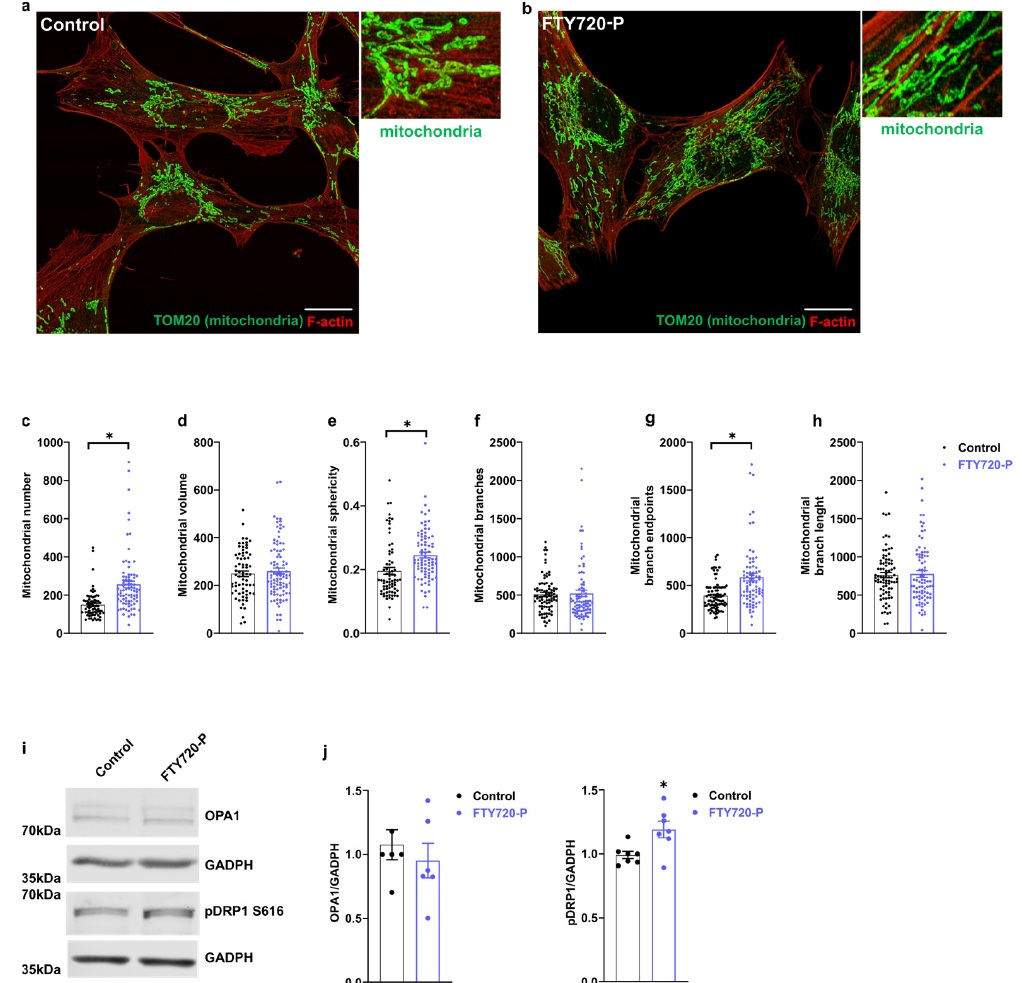
Figure 2. FTY720-P alters mitochondrial morphology. Panels ( a , b ) are representative super-resolution images (AiryScan) of mitochondrial morphology in AC16 cells. ( a ) Control AC16 cells incubated with the vehicle, ( b ) AC16 cells incubated with 100 nM FTY720-P for 48 h. The mitochondrial network was stained with anti-TOM20 antibody (green), F-actin was labeled using Rhodamine Phalloidin (red). Scale indicates 20 μ m. ( c ) Mitochondrial number, ( d ) mitochondrial volume, ( e ) mitochondrial sphericity, ( f ) mitochondrial branches, ( g ) mitochondrial branches endpoint, ( h ) mitochondrial branch length. At least 20–30 cells/sample were counted in triplicate samples per condition and per experiment. Mitochondrial analysis per cell was performed using ImageJ (NIH) plugin Mitochondrial Analyzer. Data were subjected to unpaired t -test. Data are mean ± SEM. * p -value < 0.05 vs. control cells. ( i ) OPA1 and pDRP1-S616 protein levels were detected in total protein extract of cells treated with 100 nM FTY720-P for 48 h. ( j ) OPA1 and pDRP1-S616 densitometric quantification. Data were subjected to unpaired t -test. Data are mean ± SEM. * p -value < 0.05 vs. control cells. Graphs